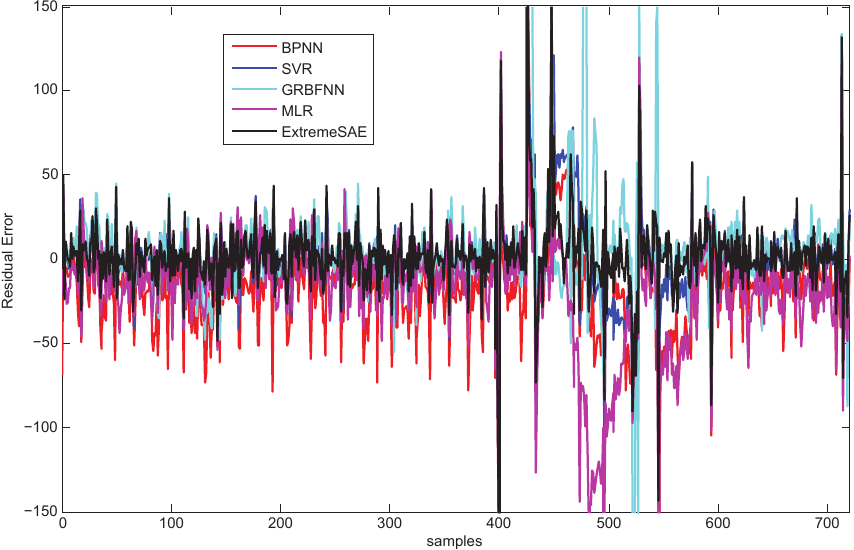
Figure 8. Residual errors of the five models in the 30 min prediction